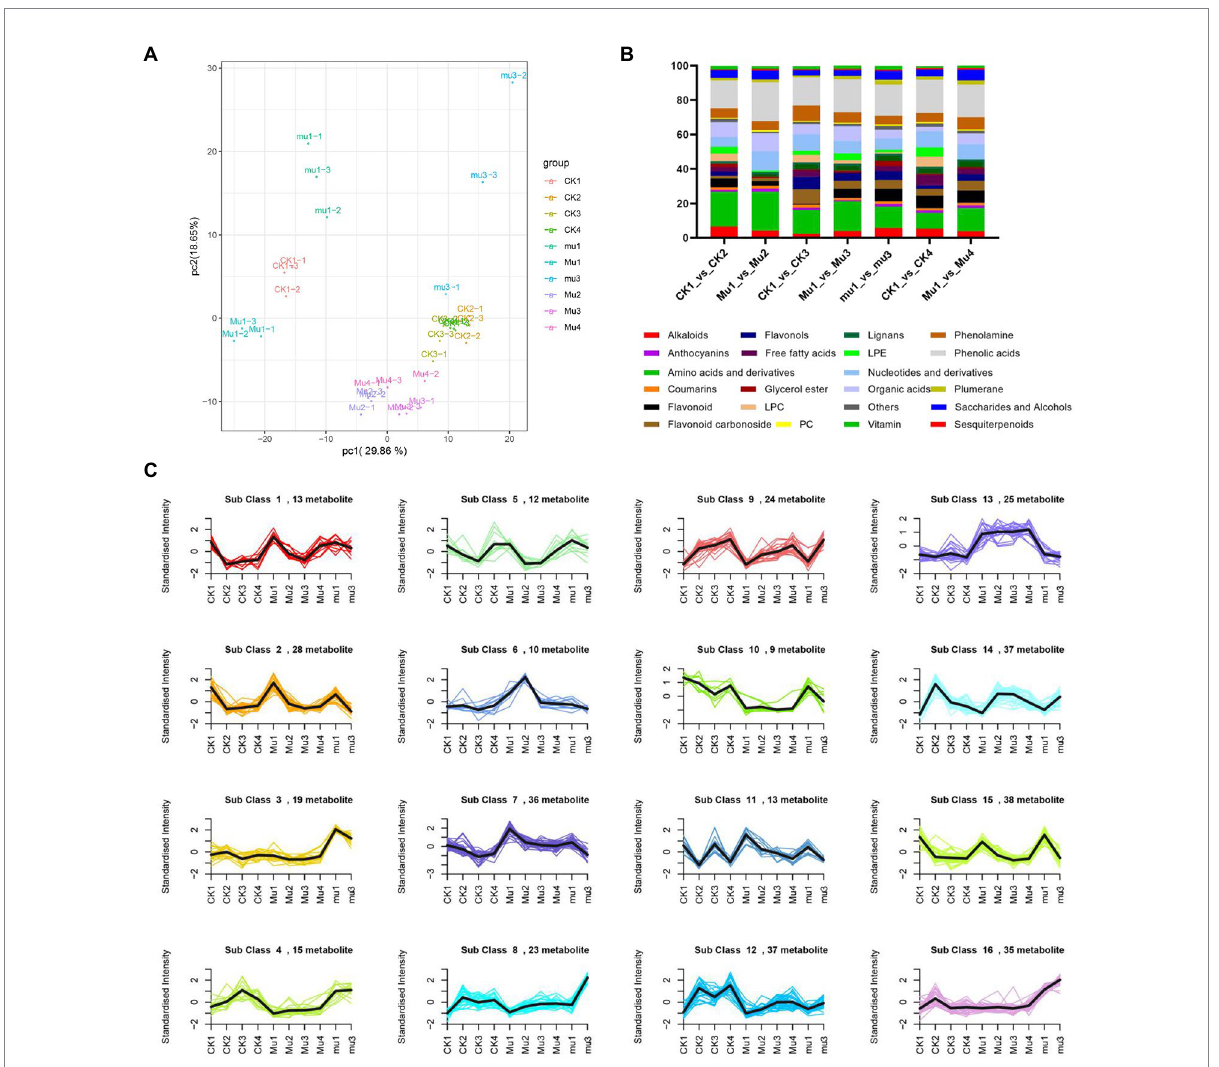
FIGURE 2 Metabolic dynamics during drought stresses and recovery in wheat. (A) PCA analysis of all samples. (B) Percentage of each kind of differentially expressed metabolites. (C) K-means clustering analysis of all the